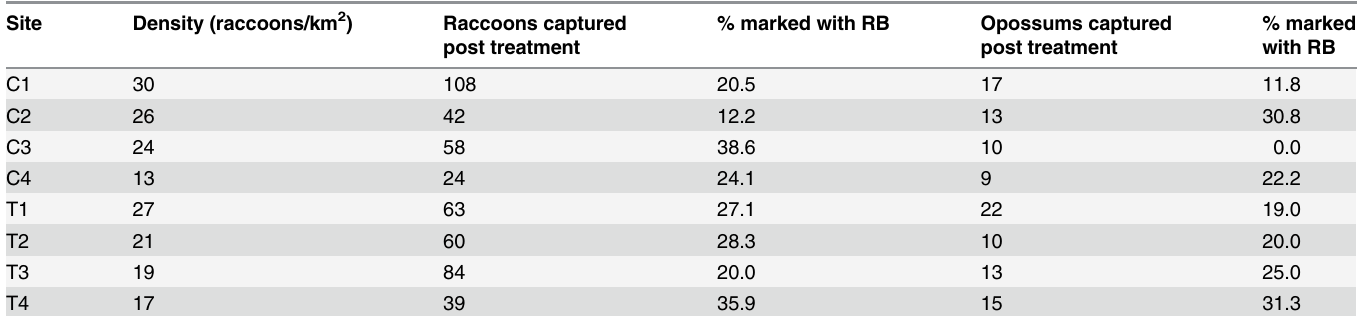
Table 1. Site-speci fi c demographic parameters and the percentage of raccoons and Virginia opossums that consumed placebo baits containing Rhodamine B (RB) for both control (C — uniform distribution of baits) and treatment (T — strati fi ed bait distribution based on resource selection information) sites in northcentral Indiana,